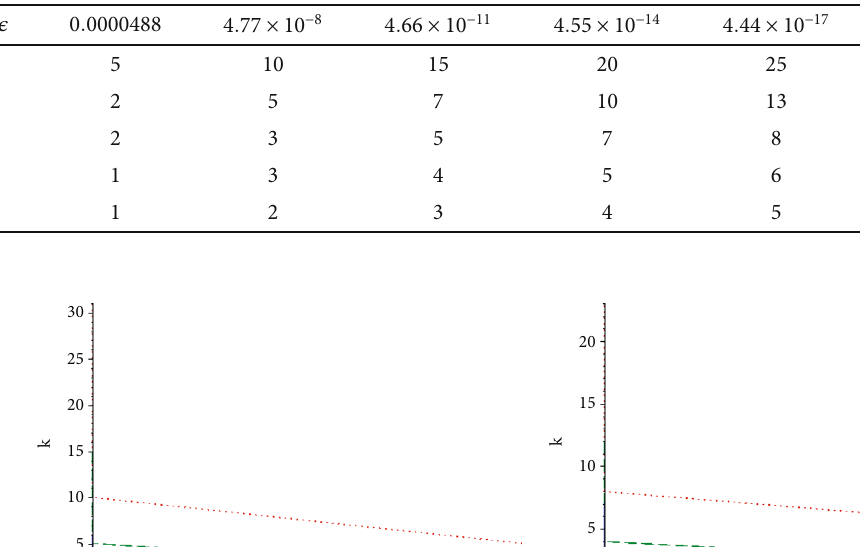
Table 3: Subdivision depth of the uniform Doo-Sabin subdivision surface at face valence n = 3 .